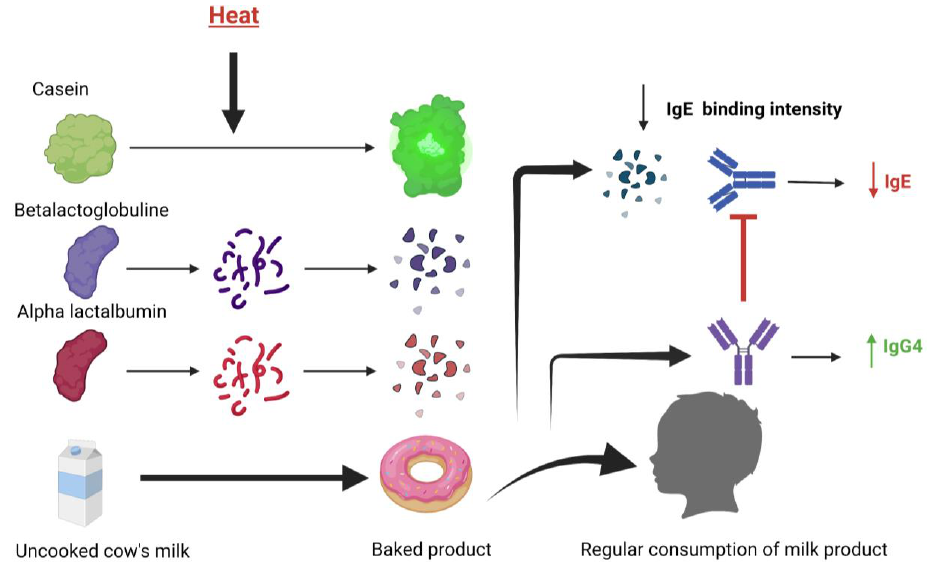
Figure 2. The mechanism of the baked milk ladder. Foods on the milk ladder undergo varying degrees of heat during the baking process. The major milk allergens, casein, betalactoglobuline, and alpha-lactalbumin, are denatured to varying degrees, with casein being the most heat resistant. This baking process alters the stability of these allergens and renders them less allergenic through decreased IgE binding. Regular consumption of these baked milk products causes the increased production of IgG4, which blocks the IgE binding to the allergen. Regular consumption of these baked milk products therefore decreases IgE levels and increases IgG4 levels, allowing for increased tolerance of milk proteins as the degree of allergenicity increases through the milk